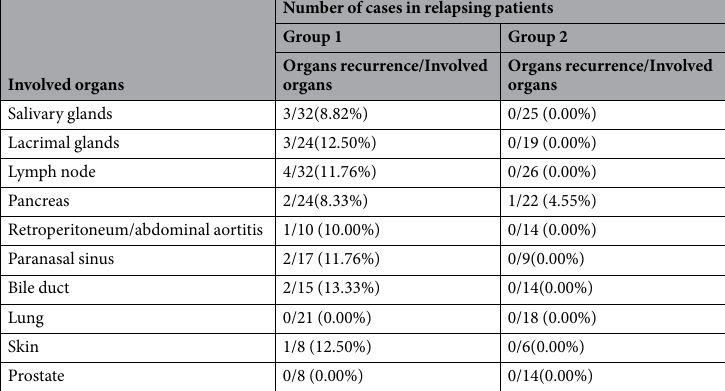
Table 3. Organs recurrence in relapsing patients with IgG4-RD.